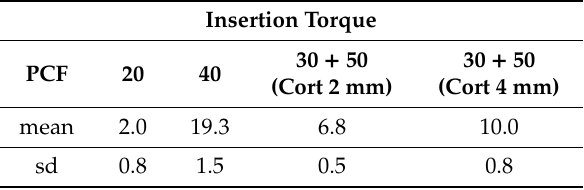
Table 1. Mean values and standard deviations (SD) for insertion torque (MIT) divided by bone block